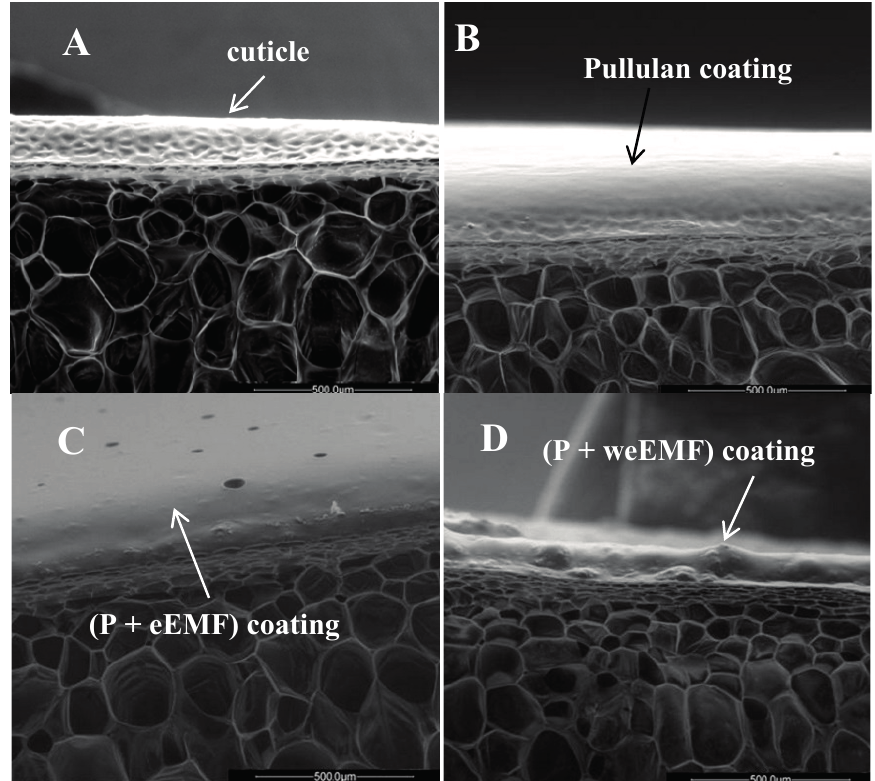
Figure 3. Microscopic image of peel surface and cross-section of uncoated peppers ( A ); and those coated with pullulan coatings enriched with meadowsweet flower extracts ( B – D ). The uneven surface cuticle with numerous microhollows in the pepper peel are marked with the arrow (A). The smooth and thin layer of pullulan coating covered all cuticle irregularities (B). Coarse surface of the pullulan coating with meadowsweet flower extracts on the pepper peel are indicated by arrows